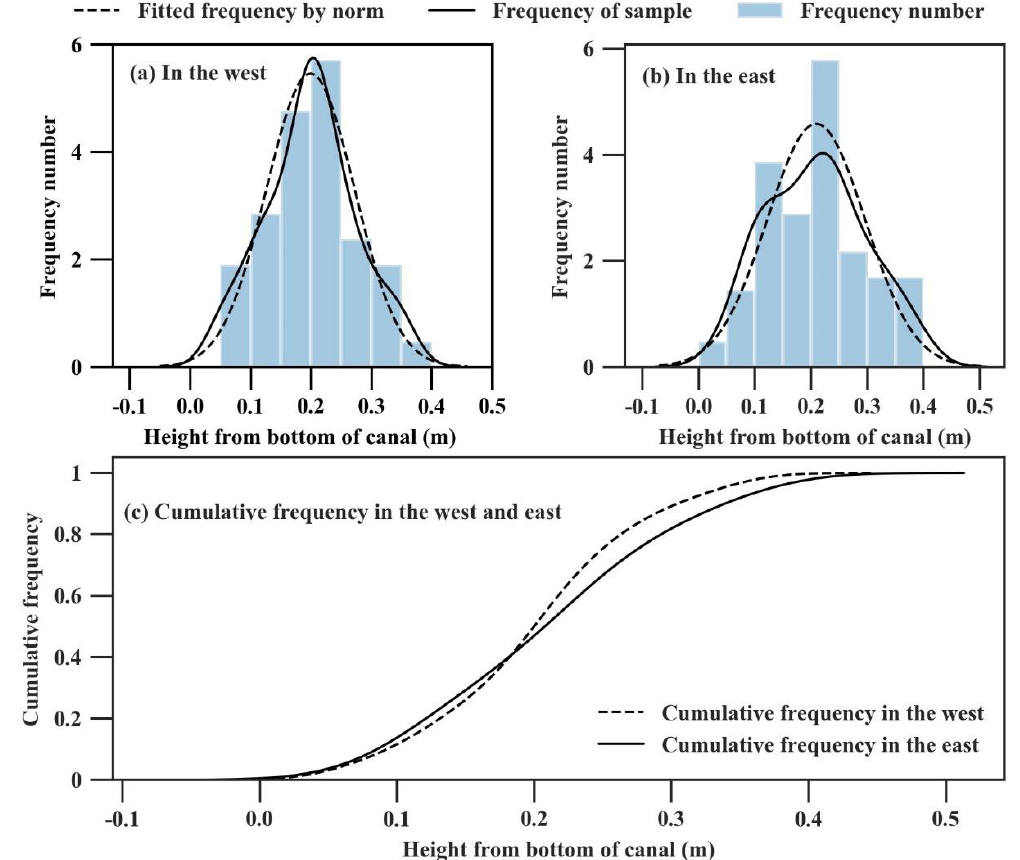
Figure 4. The number and cumulative frequency of holes in the geomembrane at different heights from the bottom of the canal. ( a ) The frequency number of holes in the geomembrane in west side of canal at different heights from the bottom of the canal. ( b ) The frequency number of holes in the geomembrane in east side of canal at different heights from the bottom of the canal. ( c ) Cumulative frequency of holes in the geomembrane at different heights from the bottom of the canal.